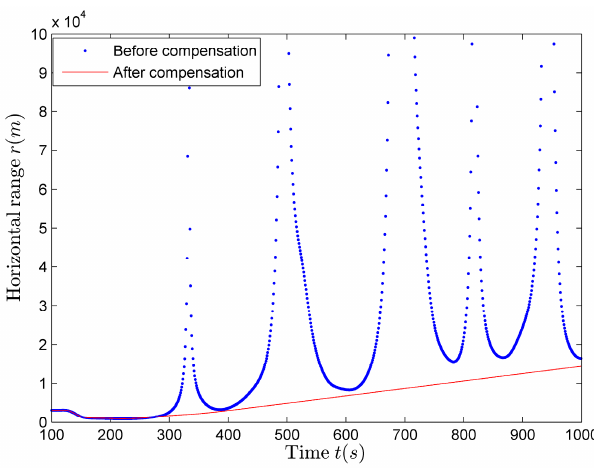
( b ) Figure 18. The horizontal distance Estimation Results if p = 900 m. ( a )  estimation results; ( b ) Horizontal distance estimation results. If we obtain the closest distance estimation results, we can estimate the horizontal distance using (22). Compared with the horizontal distance estimation results shown in Figure 18b, there is